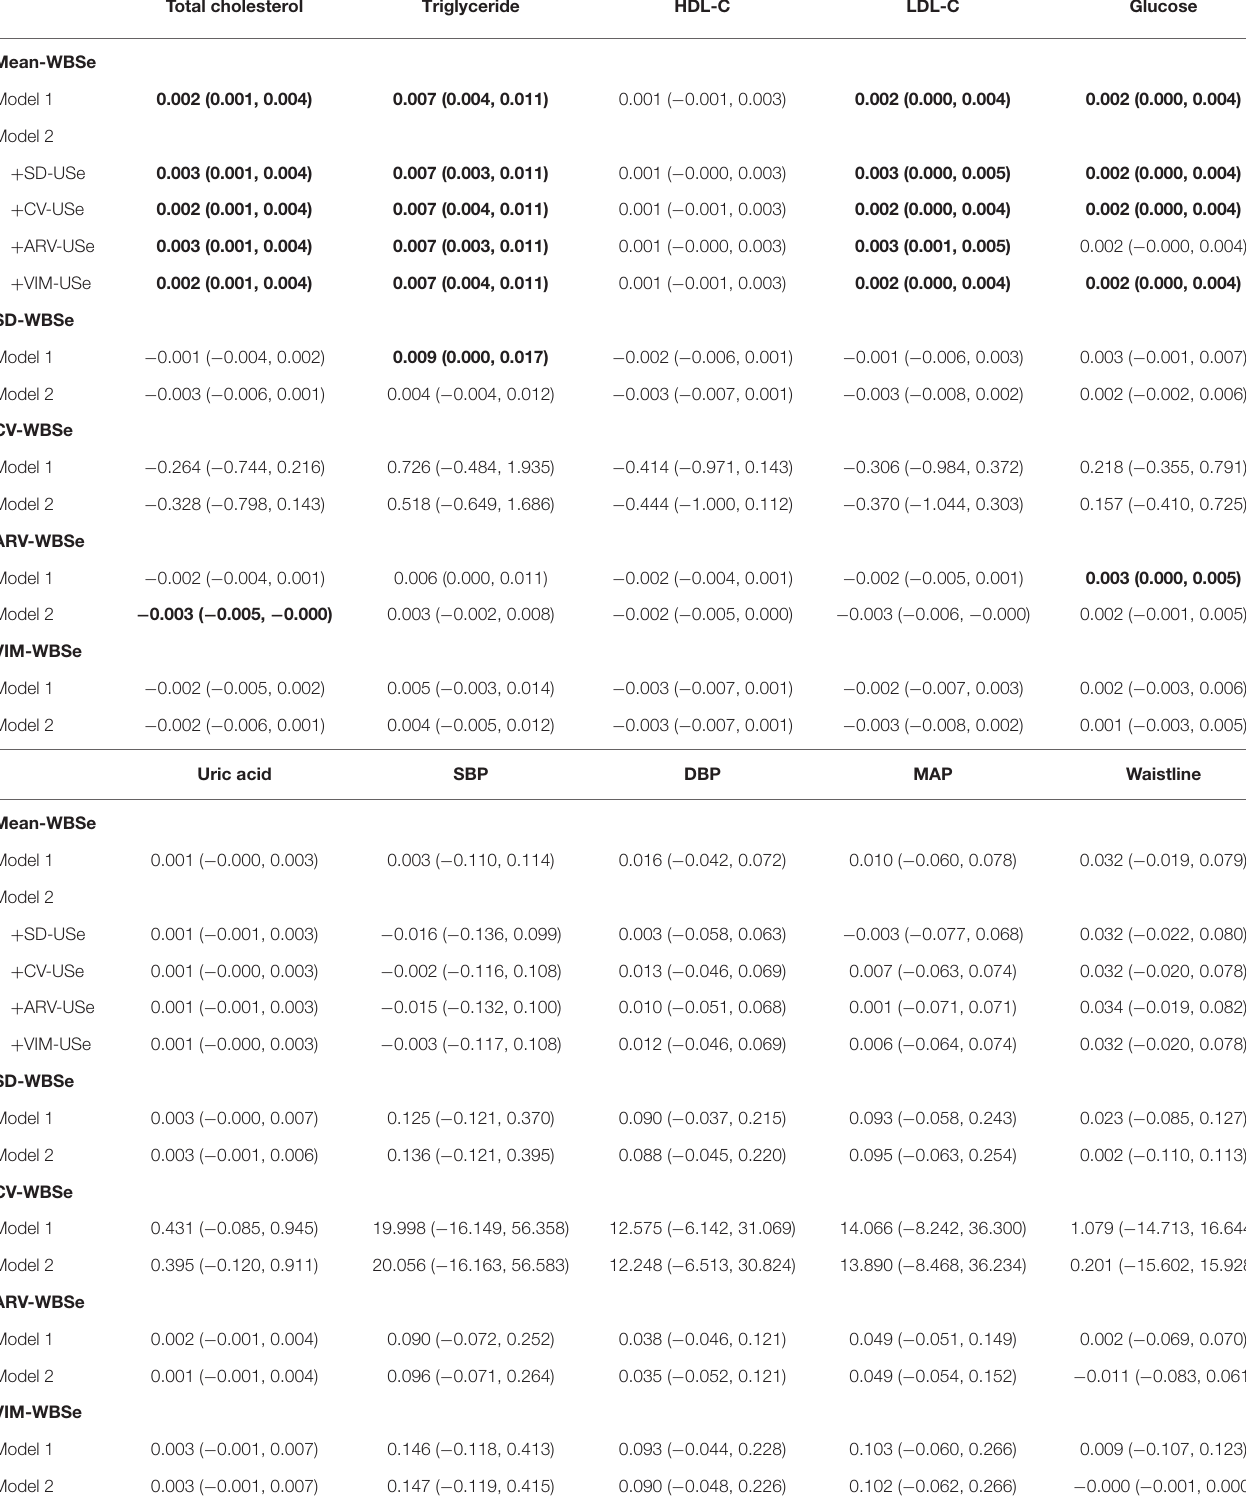
TABLE 5 | Changes and 95% confidence intervals of cardiometabolic risk factors associated with one-unit increments in VVV and IM of whole blood